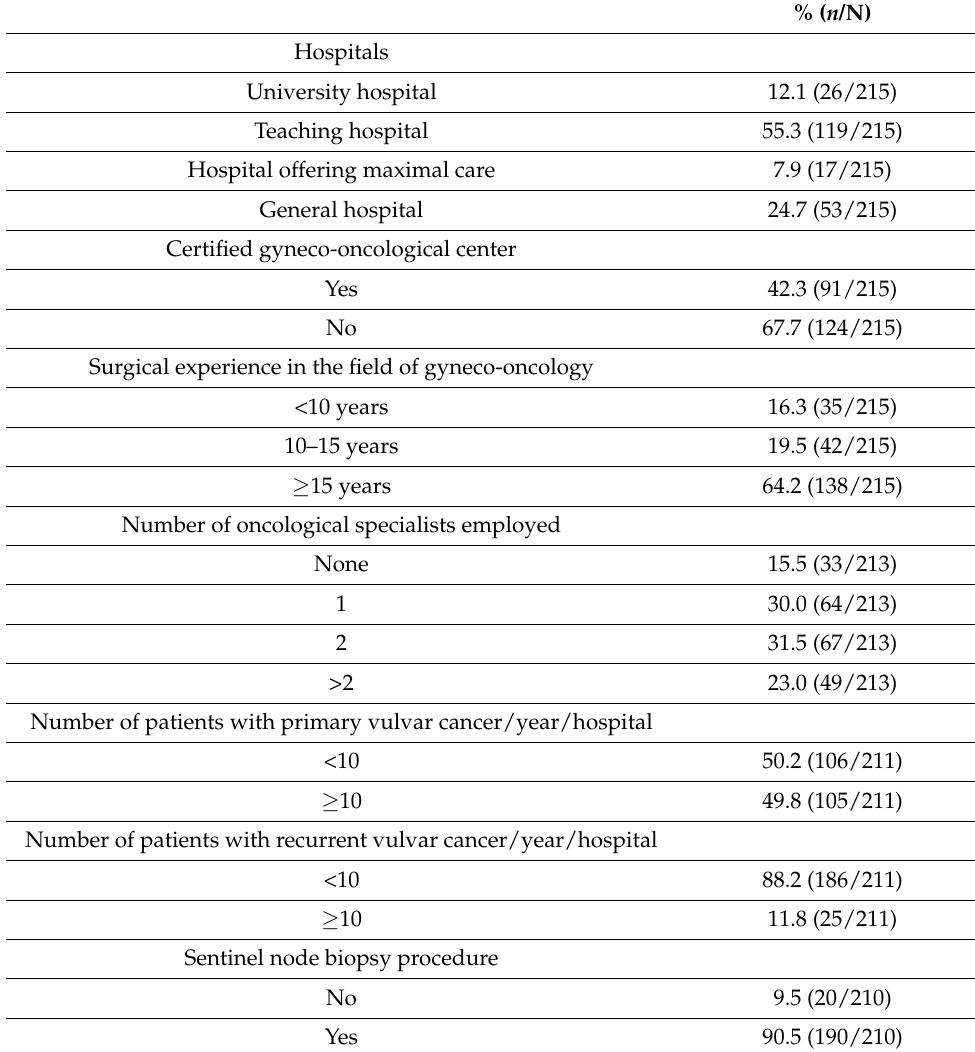
Table 2. Demographic characteristics of study